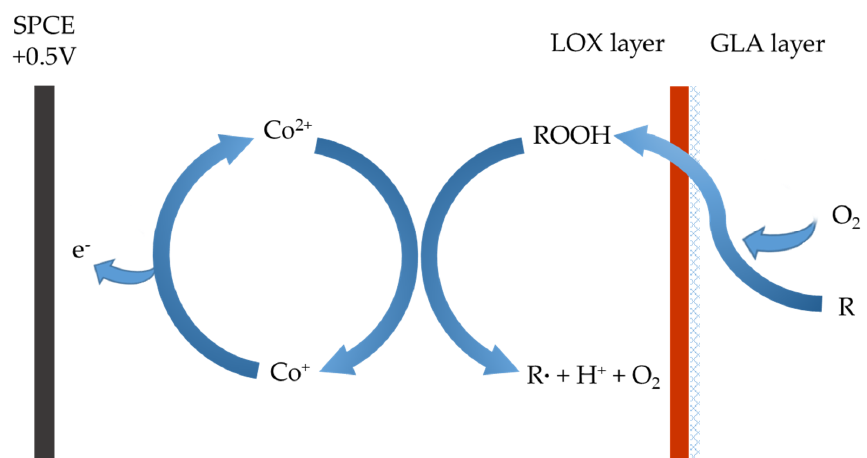
Figure 2. Schematic showing the sequential deposition of the enzyme and cross-linking agent onto Table 3. Schematic diagram of the amperometric fatty acid biosensor design and the sequence of reactions involved in its operation; SPCE = screen-printed carbon electrode; LOX = lipoxygenase; GLA = glutaraldehyde.